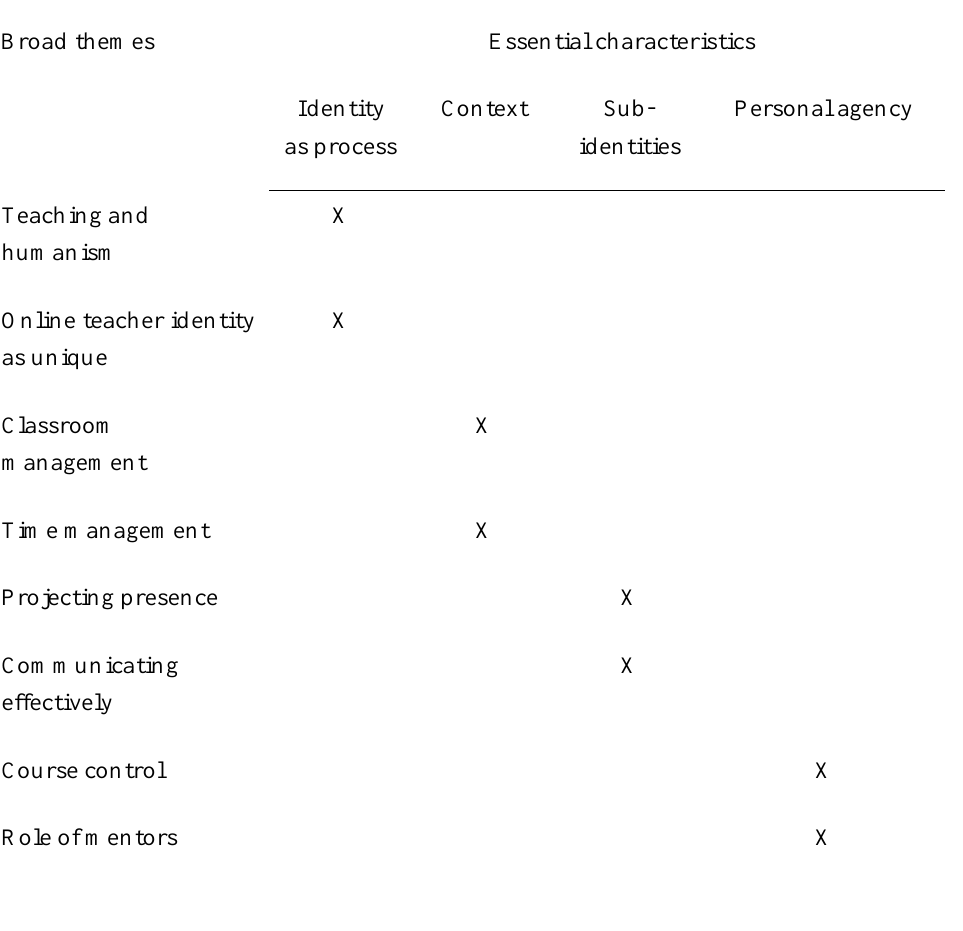
How Themes Reflect Beijaard, Meijer, and Verloop (2004)’s Essential Characteristics of